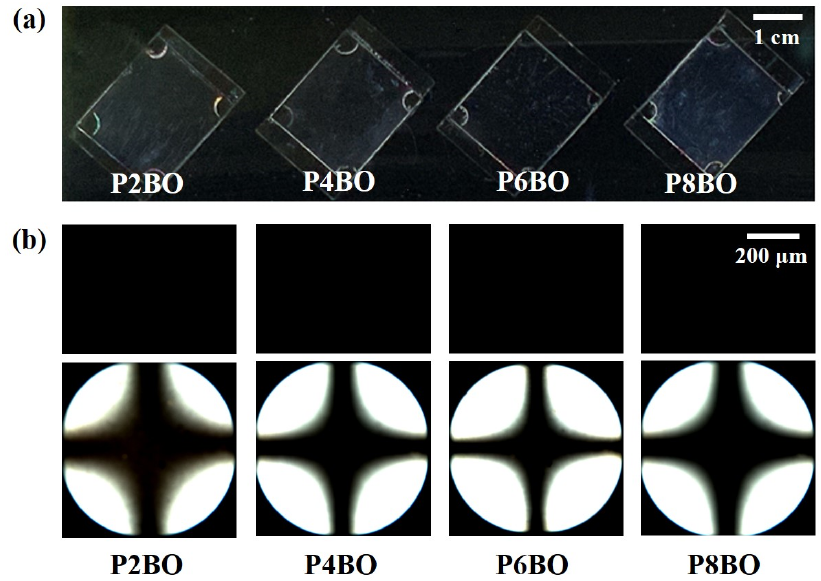
Figure 4. ( a ) Photograph, ( b ) orthoscopic (top) and conoscopic (bottom) polarized optical microscopy (POM) images of the LC cells fabricated with P2BO, P4BO, P6BO, and P8BO films. We also observed the orientation behavior of the LC molecules in P2BO# cells using 5CB to investigate the effect of the molar content of the ethylbenzoate- p -oxymethyl side group in the polymer. Figure 5a shows photographs of the LC cells made from P2BO# and P2BO films. The P2BO20 LC cells exhibited LC textures with birefringence, while uniform vertical LC orientation was observed for P2BO40, P2BO60, P2BO80, and P2BO over the entire area. Moreover, the LC orientation behavior of the LC cells fabricated with the P2BO# and P2BO films was investigated by observing their POM images for a more accu- rate analysis (Figure 5b). A random planar or a partial vertical LC orientation was ob- served in the LC cells fabricated using the P2BO20 film. However, P2BO# with 40 mol% or more of ethylbenzoate- p -oxymethyl side groups (P2BO40, P2BO60, and P2BO80) and P2BO films produced stable vertical LC orientation, as shown by the dark orthoscopic images and the Maltese cross patterns observed in the conoscopic images. The Maltese cross patterns in the conoscopic POM images of the P2BO40, P2BO60, P2BO80, and P2BO films indicate that there are no discernible differences in the LC orientation of polymers with different molar fractions of ethylbenzoate- p -oxymethyl in their side groups. The ver- tical orientation of the LC cells was observed for P2BO40, which contained only 40 mol% ethylbenzoate- p -oxymethyl groups. This result suggests that high similarity between the molecular structure of the LCs and the alignment layer assists with the vertical orientation of the LC molecules.